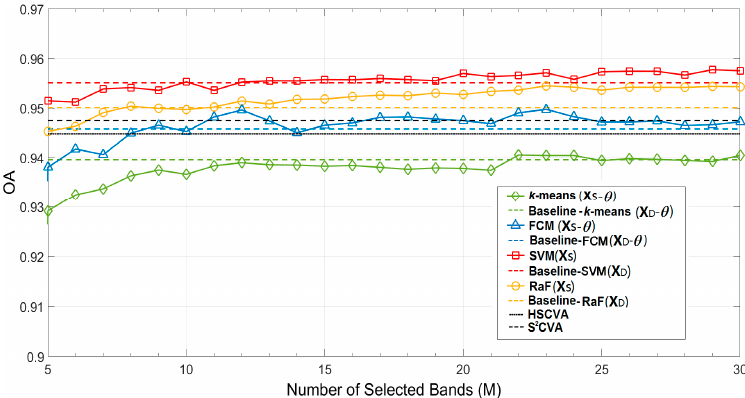
Table 4. For the two supervised approaches (i.e., SVM-based and RaF-based), training samples (see Table 2) were used to train the classifiers based on the M -dimensional X S . Multiple CD results are